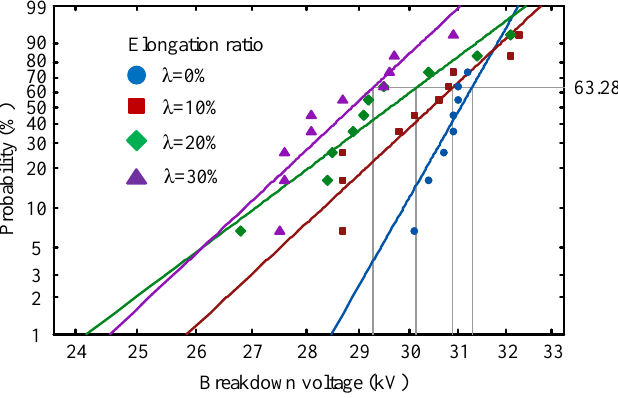
Figure 6. AC breakdown voltage of polyethylene at different elongation ratios.